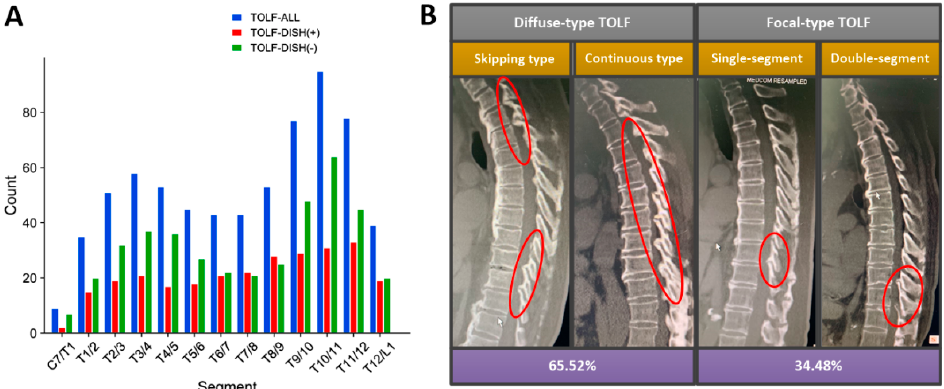
Figure 3. Distribution characteristics of TOLF between DISH+ and DISH − Group. ( A ) Segmental distribution. DISH − group showed distinct bimodal distribution, which was consistent with the overall distribution of TOLF, but the two peaks in DISH+ group became relatively flat. ( B ) DISH+ group was more susceptible to the diffuse-type TOLF (continuous-type and skipping-type) rather than focal-type TOLF (single-segment and double-segment).